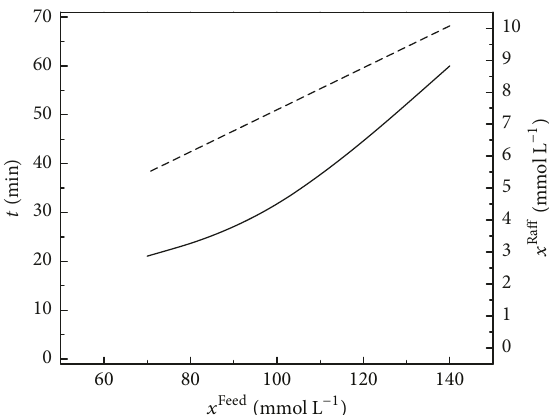
Figure 14: Plot of 𝑥 (dashed line) and 𝑦 (solid line) as a function of time in the batch extraction unit. 𝑊 Ads = 1334 kg, 𝑉 Feed = 0.24 m 3 , 𝑉 Solv = 4.8 m 3 , 𝑥 Feed = 140mmol L −1 , T = 30 ∘ C.